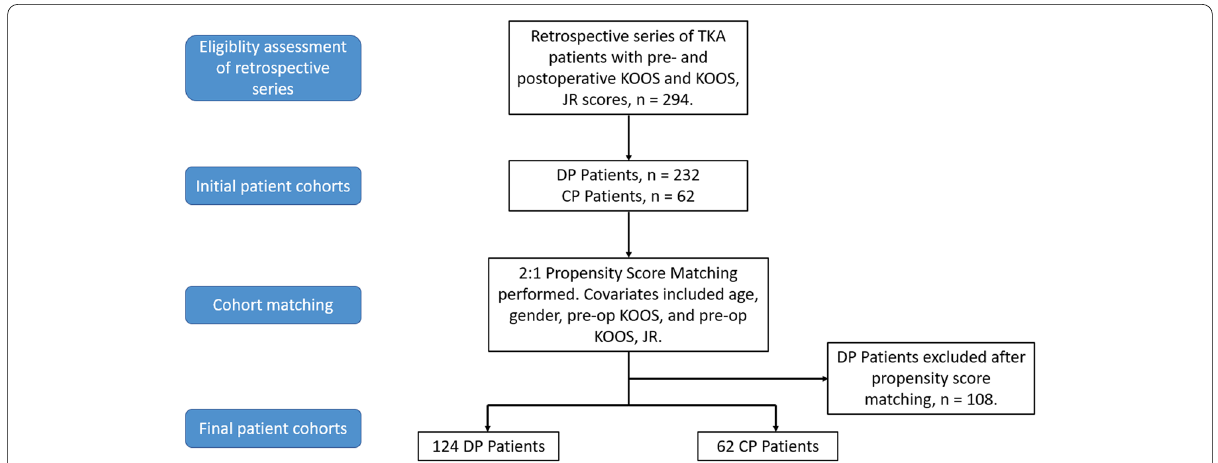
Fig. 1 Flow chart of patient screening and cohort matching